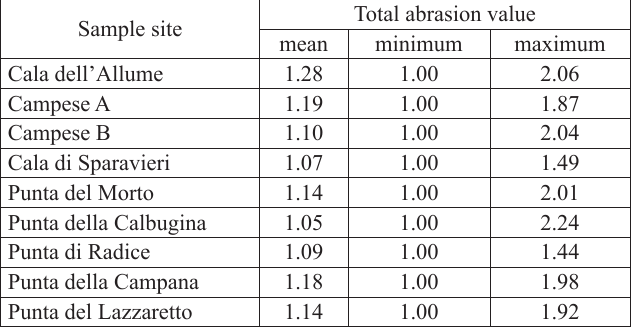
Table 3. Description of the total abrasion values (V A ) for the studied sample sites.